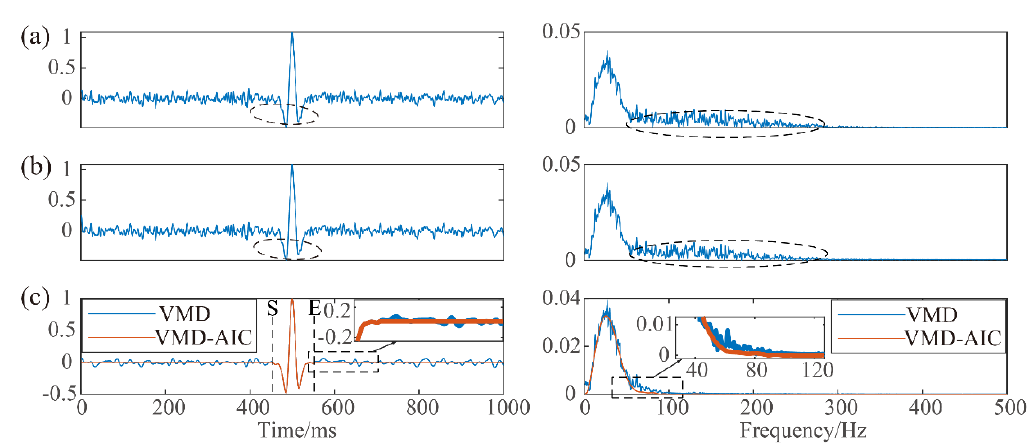
Figure 7. Noise reduction results of synthetic signals by di ff erent methods. ( a ) EEMD; ( b ) complete EEMD (CEEMD); ( c ) VMD and VMD-Akaike information criterion (AIC). The letter S means the start position of the MS signal segment, and the letter E indicates its end position. The portion in the solid box is an enlarged view of the portion in the dotted box.